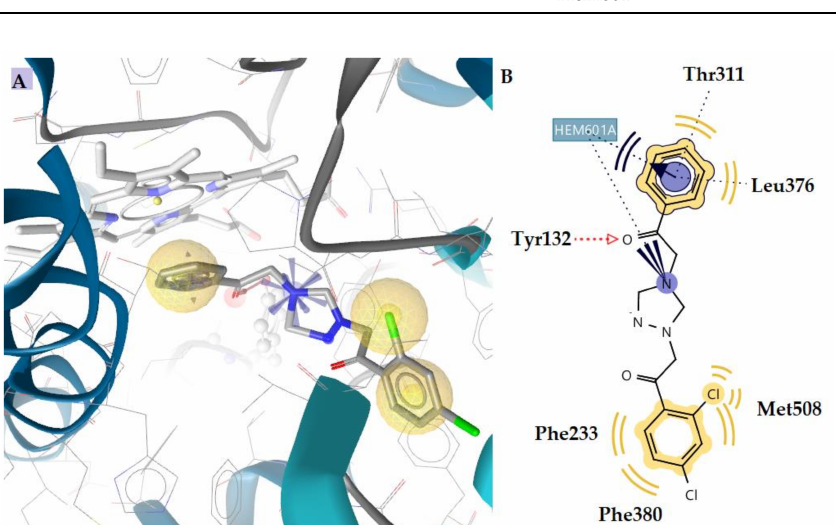
Figure 2. Docking pose of the most active compound 19 ( A ) and 2D diagram ( B ) in lanosterol 14 α - demethylase of C . albicans (CYP51 ca ). Red-dotted arrows indicate H-bond, blue arrows positive ioniz- able, blue spheres indicate the aromatic, and yellow spheres indicate the hydrophobic